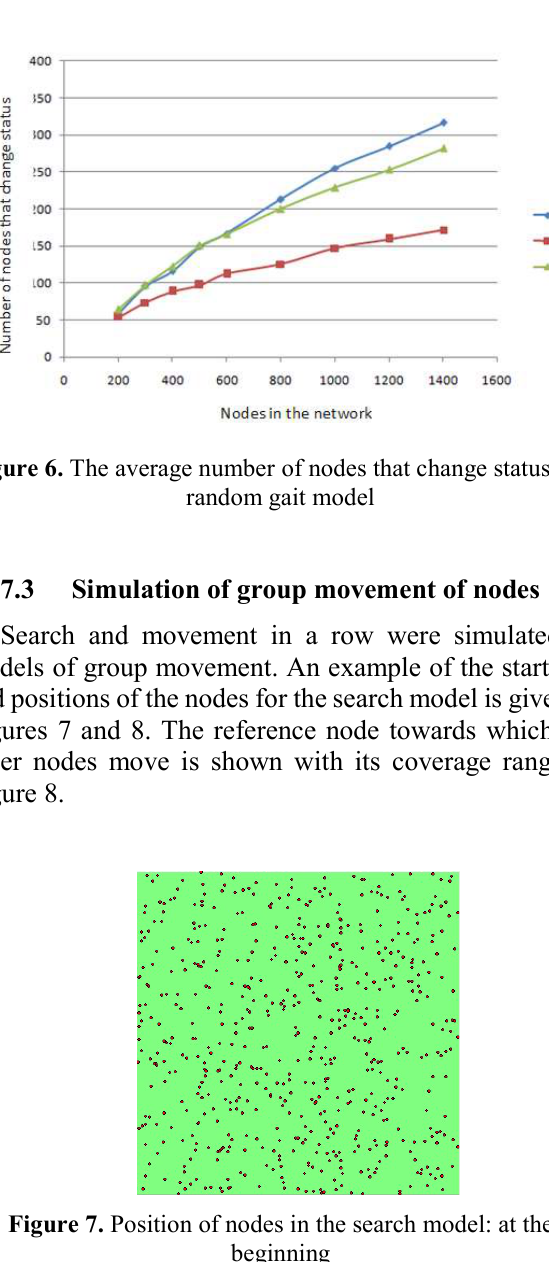
Figure 7. Position of nodes in the search model: at the beginning